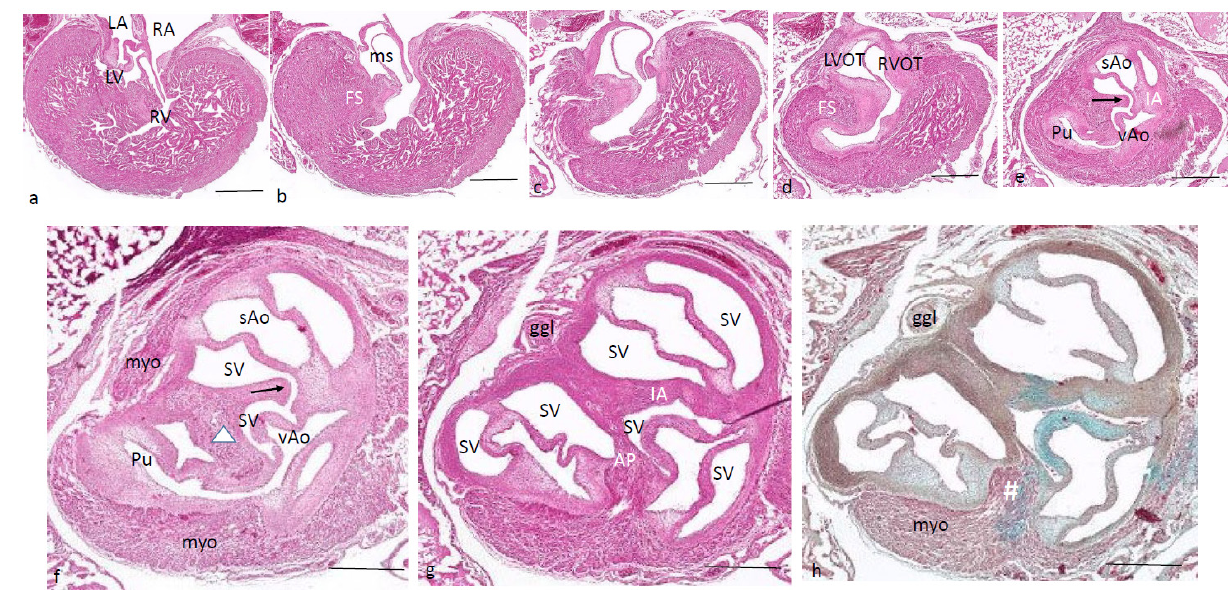
Figure 8. Alligator embryo older > than F stage 25. HE-stained Figure ( h ) is, in addition, Alcian blue stained. Figure ( a – h ) from AV valves to semilunar valves. Figure ( a – d ), the mesenchymal septum is inserted between the right and left ventricular compartments separating both ventricles. It reaches from the tip of the folding septum near the septal cushion (in Figure ( a )) towards the IA septum (in Figure ( d , e )). The communication between visceral and systemic aortas is still patent (Figure ( d )). Figure ( e , f ), here, the IA septum is interrupted by the tunnel of the foramen of Panizza (arrow). Figure ( g , h ), both the AP septum and the IA septum are complete at this level. Key to the symbols # ventral myocardium, part of AP septum; * (presumably) left-sided neural crest cells, part of AP septum; + (presumably) right-sided neural crest, part of IA septum; Δ dorsal myocardium, part of AP septum. Magnification Figure ( a – e ), bar 200 µm; ( f – h ), bar 500 µm.